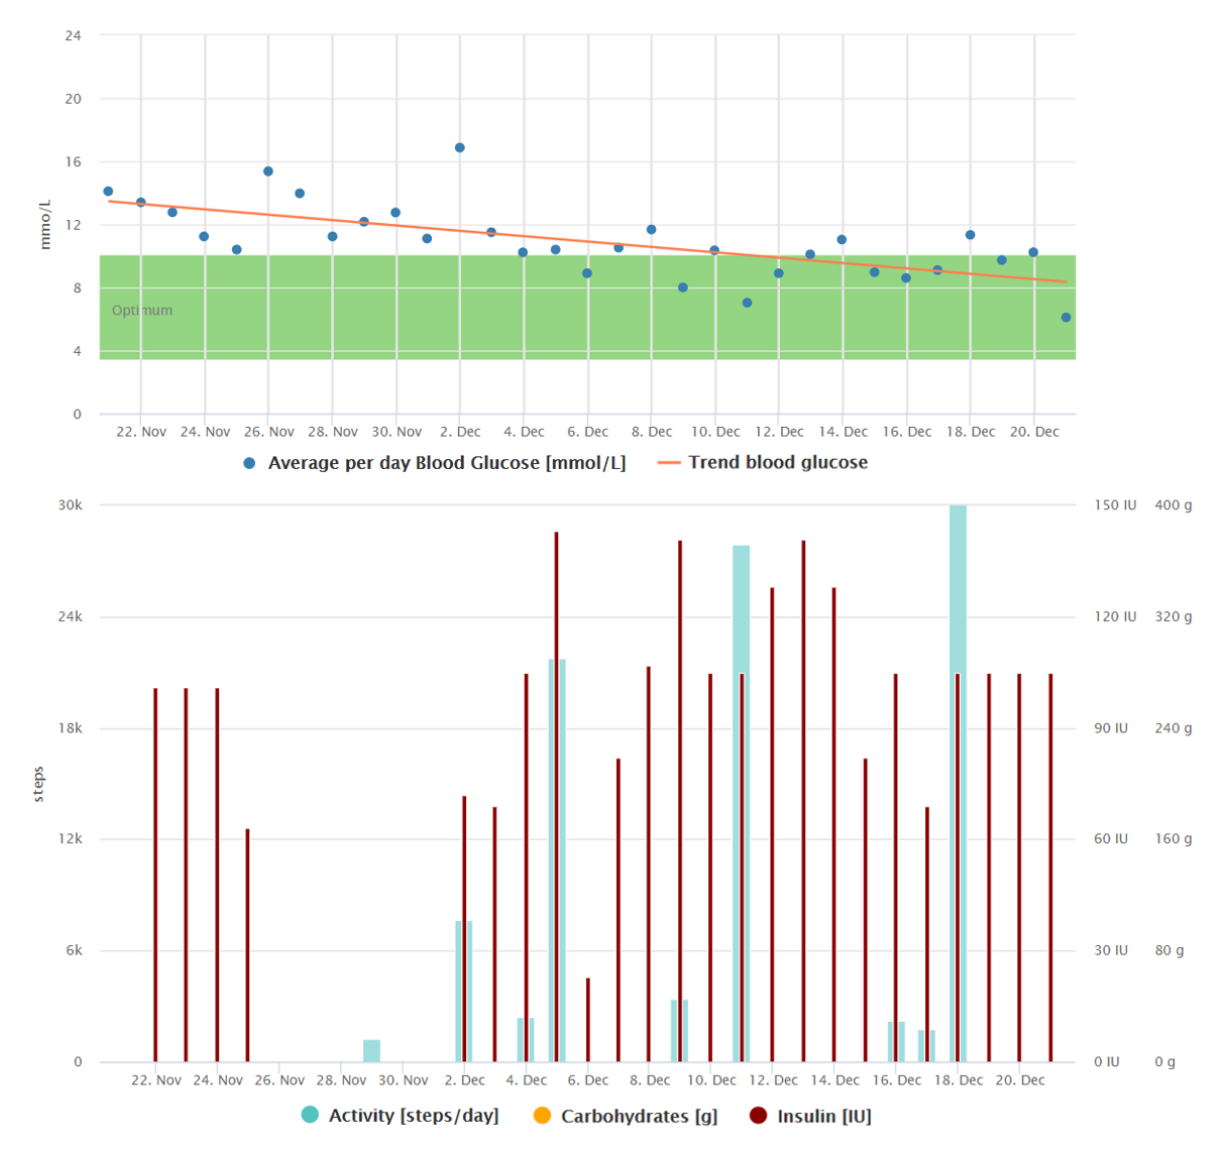
Figure 7. Graphical interpretation of 1-month data registrations of the patient from case study 5, visualized by the Diani Web app. We can observe the decreasing trend of average daily blood glucose during the first month of using the telemedicine